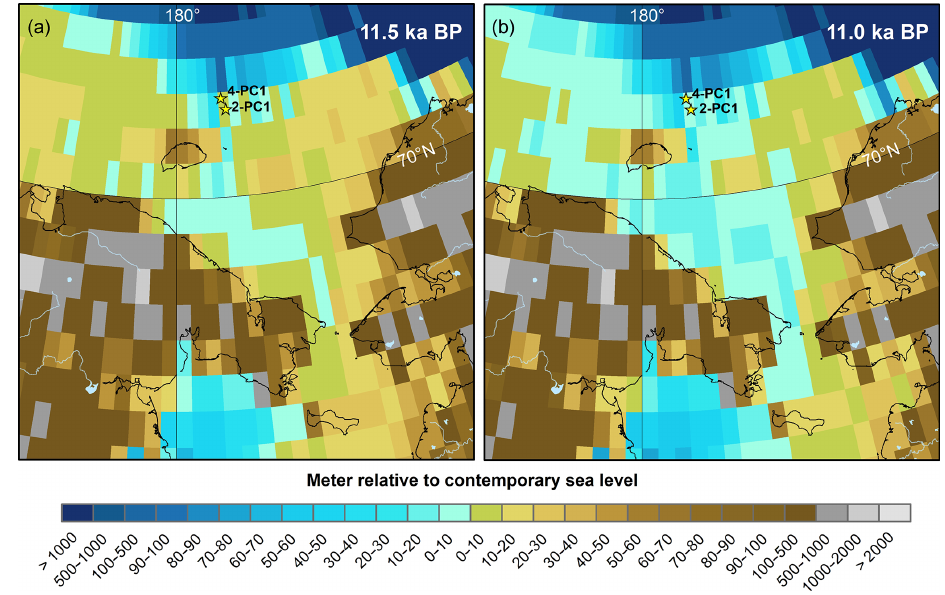
Figure 8. Paleotopography of the Beringia region based on the model ICE-6G_C (Peltier et al., 2015) at 11.5calkaBP (a) and 11.0calkaBP (b) . The Bering Strait is first flooded according to ICE-6G_C at 11kaBP, which is consistent with the age estimate in our study. The coring sites of 2-PC1 and 4-PC1 are shown as references. Blue indicates depths and green to brown indicates heights above sea